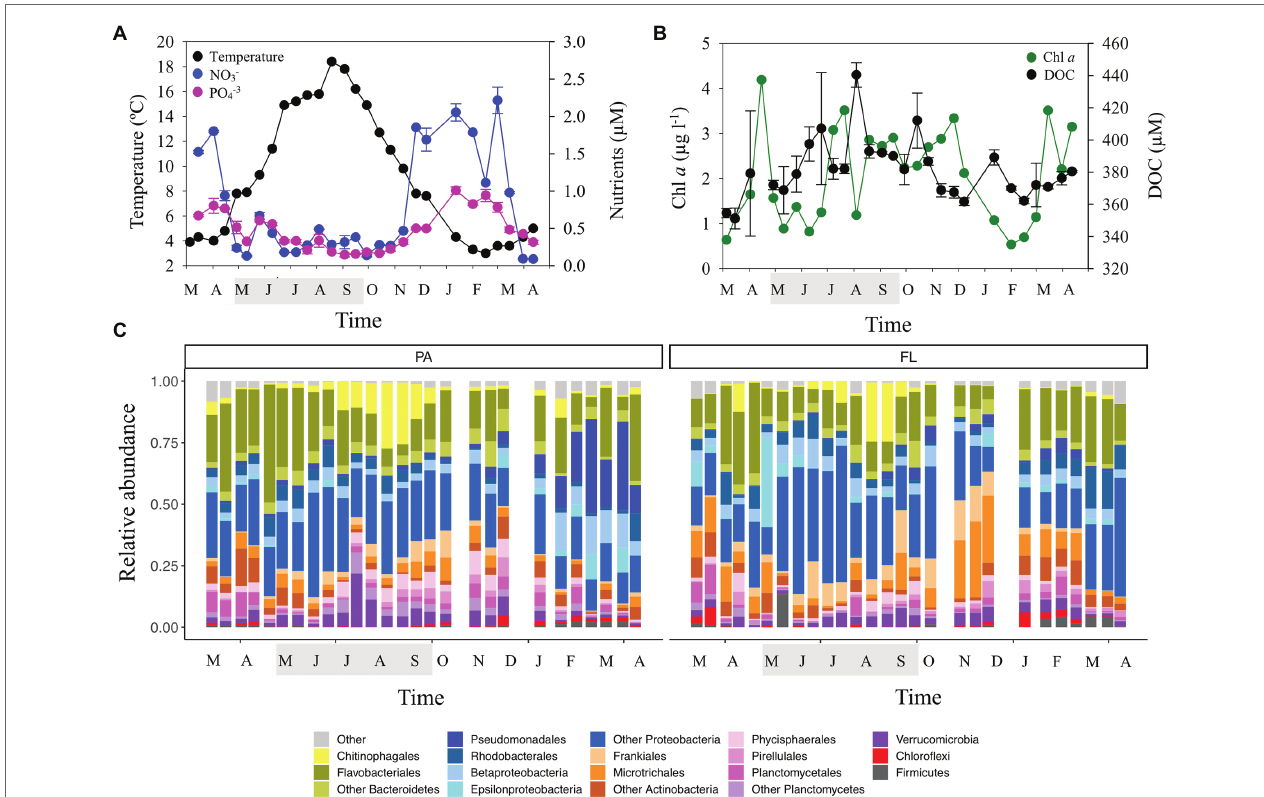
FIGURE 1 | Temporal evolution of: (A) temperature, nitrate, and phosphate concentrations, (B) chlorophyll a (Chl a ) and dissolved organic carbon (DOC) concentrations, and (C) taxonomic composition of bacterial communities in the two size-fractions studied: >3 μ m (particle-attached; PA) and <3 μ m (free-living; FL). The shaded period in the x-axis corresponds to